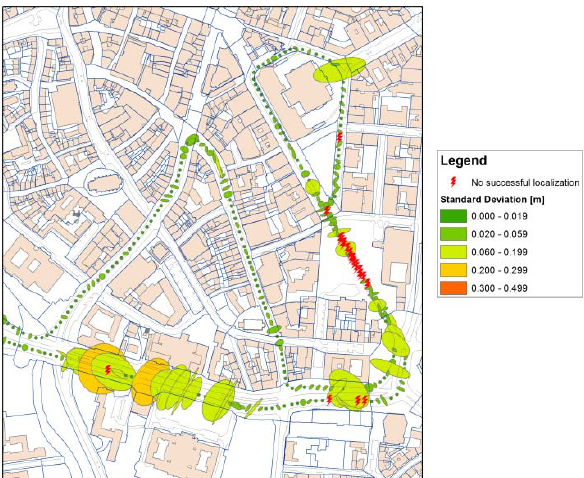
Figure 13: Localization results on a large street (bottom) and in the city center of Hannover, Germany.